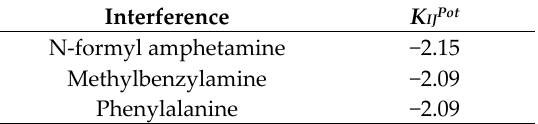
Table 2. Selectivity coefficient of the amphetamine-selective